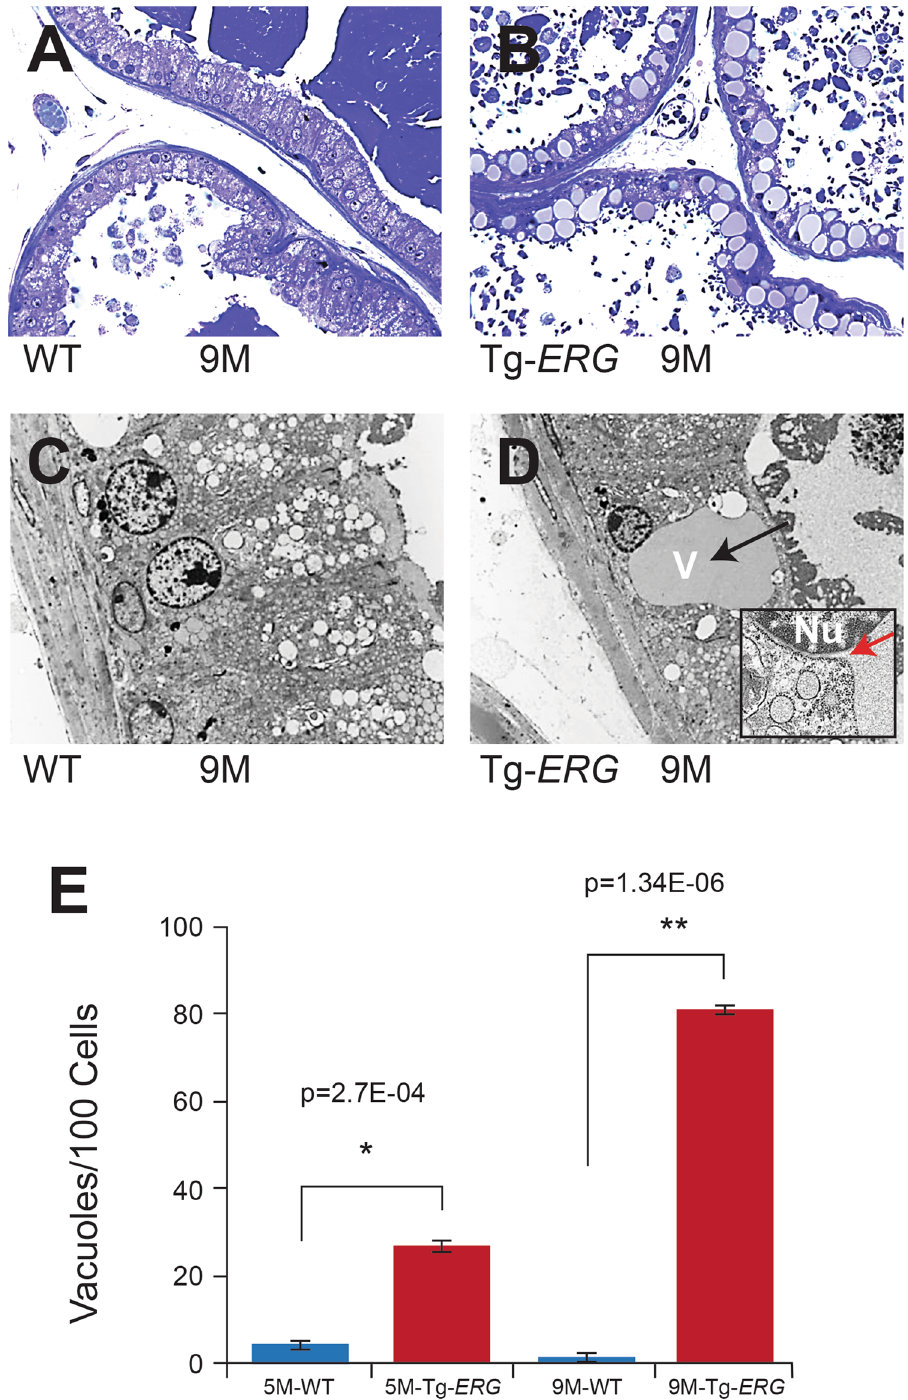
Figure 2. ERG induces histo-morphological phenotype in mouse prostate glands. Toluidine blue stained plastic sections of wild-type mouse prostate glands ( A ) display well-organized, terminally differentiated, tall columnar luminal epithelial cells with basally positioned nuclei. Tg- ERG mouse ventral prostate ( B ) luminal epithelial cells displayed cuboidal cells with irregularly bordered nuclei and increased vacuolization. TEM analysis of the wild-type ( C ) ventral prostates displayed tall columnar luminal cells, basal nuclei and large number of clear secretory vesicles in the apical cytoplasm. Tg- ERG mouse prostate epithelial cells ( D ) displayed an abnormally large vacuole adjacent to nuclei (red arrow showing the extension of nuclear envelop into ER). The quantitative analysis of morphological changes (appearance of vacuoles in the Tg- ERG mouse prostates) in the luminal epithelial cells was performed on Toluidine blue stained plastic sections of Tg- ERG and wild-type prostate glands of 5 and 9 months-old mice ( E